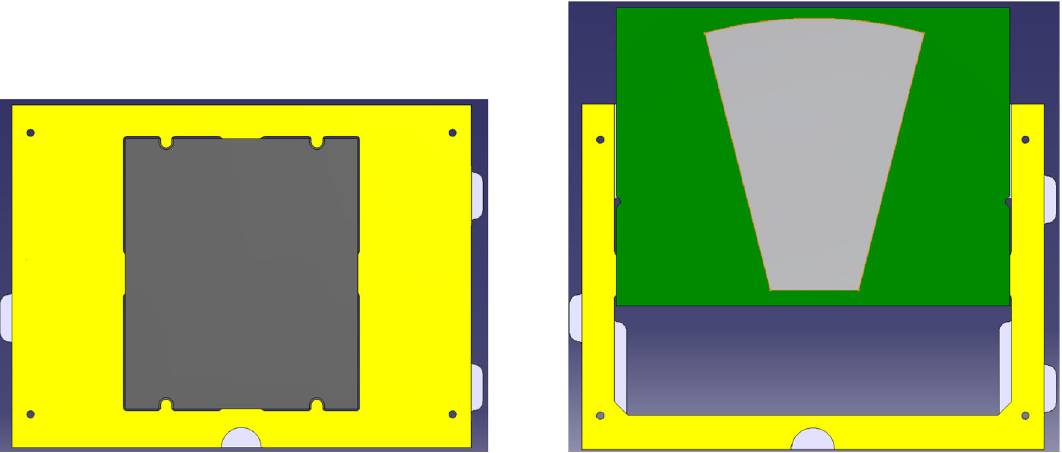
Fig. 3 Detector layers supporting frames. Left-hand side: tungsten absorber (gray) in a permaglass frame (yellow). Right-hand side: sensor (gray) PCB (green) partially retracted from a permaglass frame